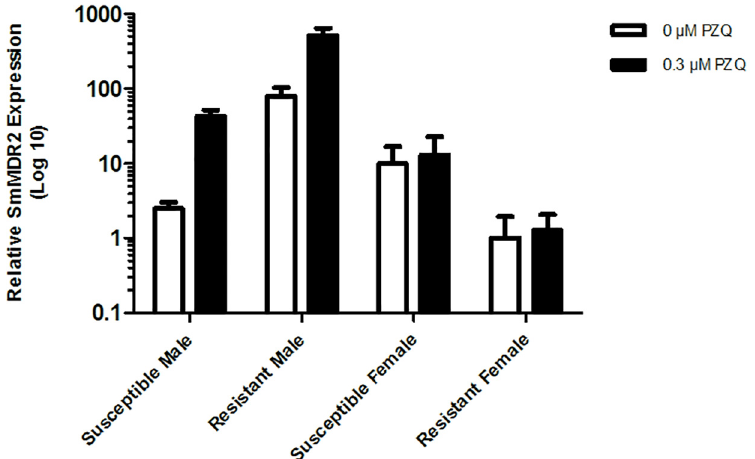
Fig 12. Relative expression level of SmMDR2 RNA. In males and females of PZQ-susceptible and PZQ- resistant parasite strains in the presence and absence of PZQ. White bars — RNA from adult worms without exposure to PZQ, and black bars — RNA from adult worms after exposure to PZQ. The n-fold changes were determined by quantitative RT-PCR using S . mansoni 18S ( Sm18s ) RNA of each group was used as a reference gene. Differences of the relative level of SmMDR2 between the groups was done using ANOVA, p <